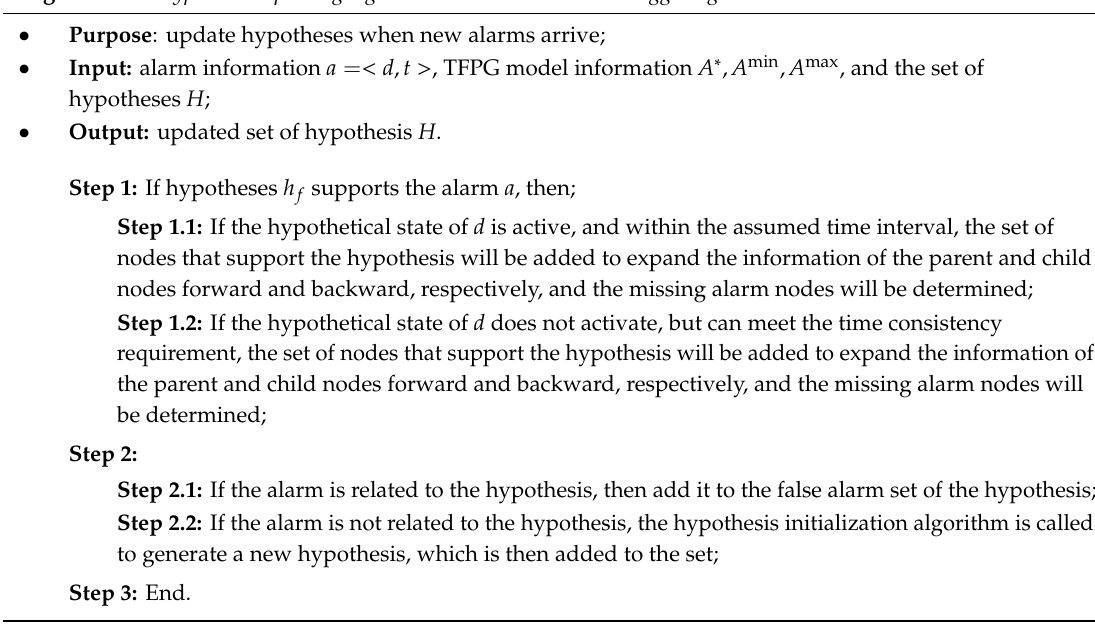
Algorithm 5. Hypothesis updating algorithm based on new alarm